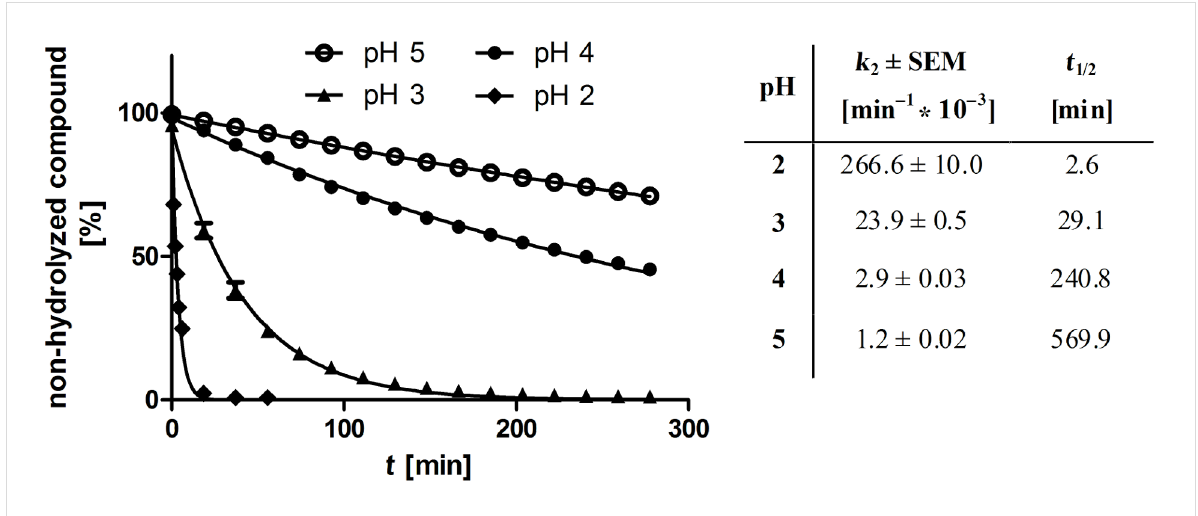
Figure 4: Kinetic analysis of hydrolysis of reference compound 8a in dependency of different pH values and calculation of kinetic parameters. Curves and k 2 values were calculated assuming a pseudo-first-order kinetic as described in Equation 3. All experiments were performed in triplicate (mean ±